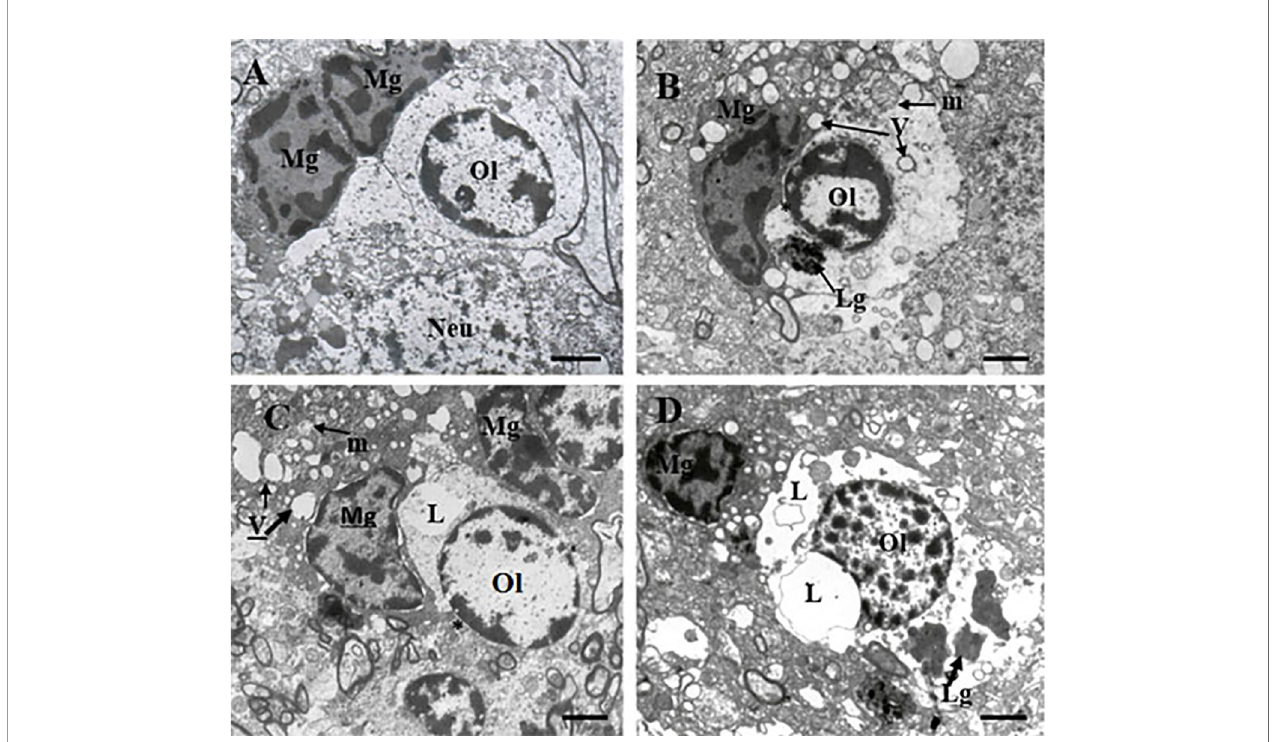
FIGURE 1 | These micrographs from layer 5 of the prefrontal cortex show microglia adjacent to oligodendrocytes from control brain (A) and from the SPPS subgroup (B – D) . “ Resting ” microglia (A) . Ameboid (activated) microglia (B) . Dystrophic changes in microglia and oligodendrocytes: cytoplasm vacuolation, damaged mitochondria, accumulation of lipofuscin granules (C, D) . Microglial cytoplasm contacts with oligodendrocyte nucleus ( B , C , *). Focal lysis (L) of cytoplasm of oligodendrocytes adjacent to microglia (C, D) . Mg, microglia; Ol, oligodendrocyte, m, mitochondria (arrows); V, vacuole (arrows), Lg, lipofuscin granule (arrows). (Scale bars = 1